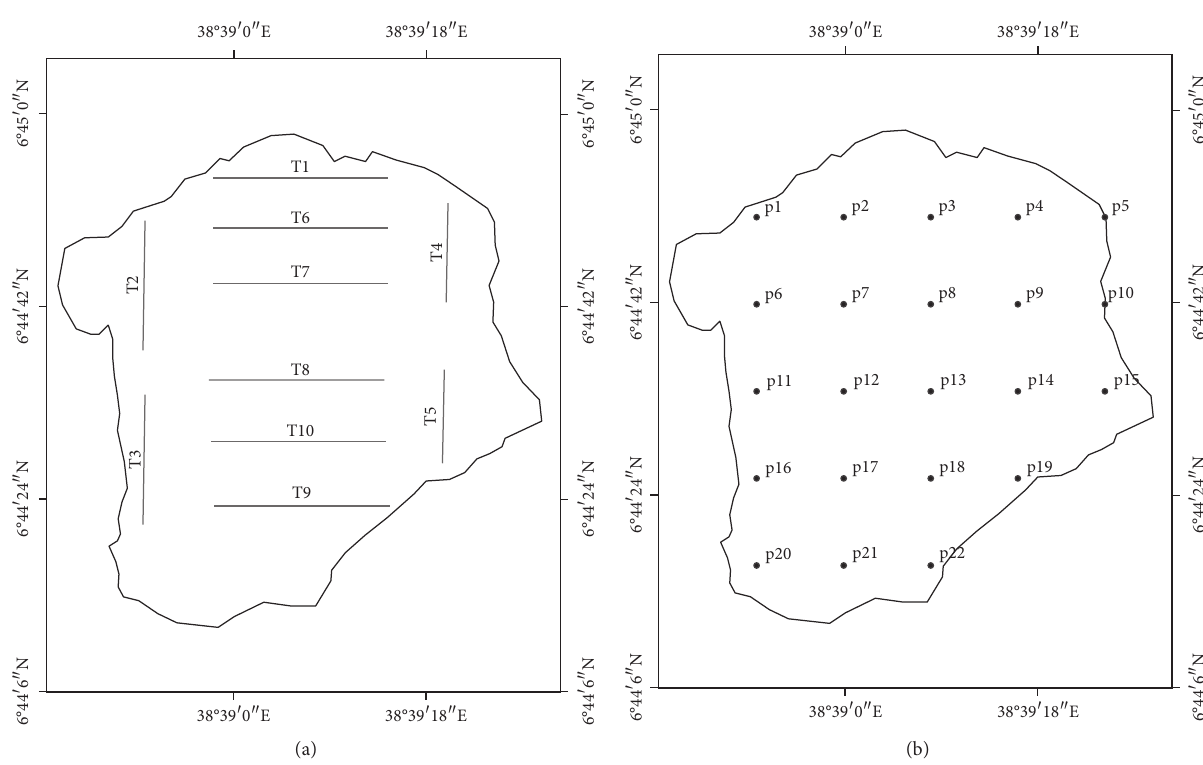
Figure 5: Transects (a) and plots (b) layout at Geremba Mountain, southern